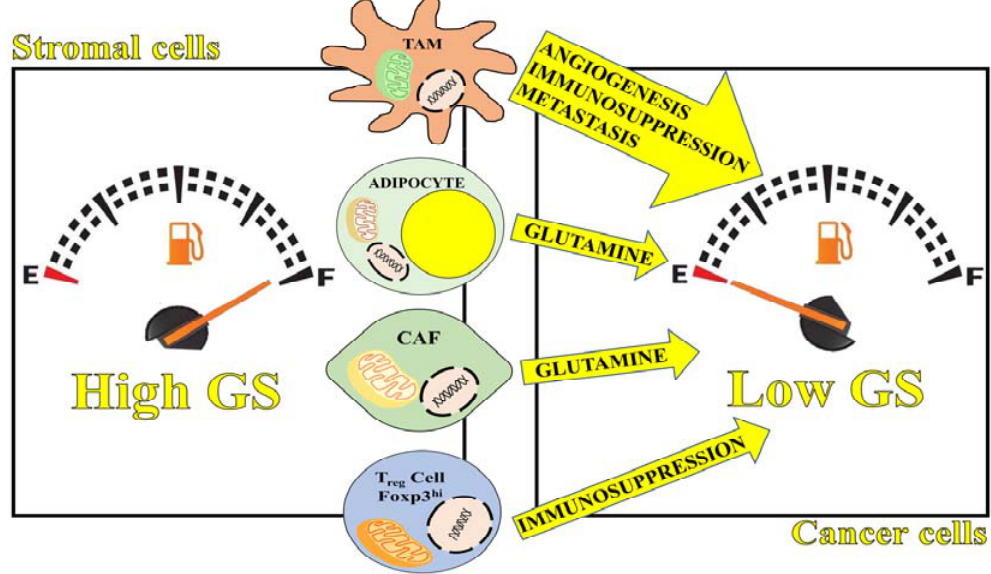
Figure 2. GS expression in cancer versus tumor microenvironment (TME) cells. Reduced ability to synthesize GS, displayed by some cancer cells, might significantly modify the composition of the extracellular milieu in terms of nutrients availability (such as glutamine). Based on the evidence that starvation increases GS levels (by means of forkhead box O3 (FOXO3A) and post-translational protein stabilization), glutamine depletion induced by glutamine dependent-cancer cells might trigger GS expression in cancer associated fibroblasts (CAFs), macrophages, adipocytes and T cells. In these cells glutamine synthesis is known to mediate a metabolic and functional reprogramming. In this way, the inability to synthesize glutamine (reduced GS expression) displayed by some cancer cells might be one of the elements capable of inducing a metabolic pressure on the TME, eventually reprogramming CAFs, adipocytes and immune cell function toward a protumoral phenotype. TAM: tumor-associated macrophages; T reg : Regulatory T cells.